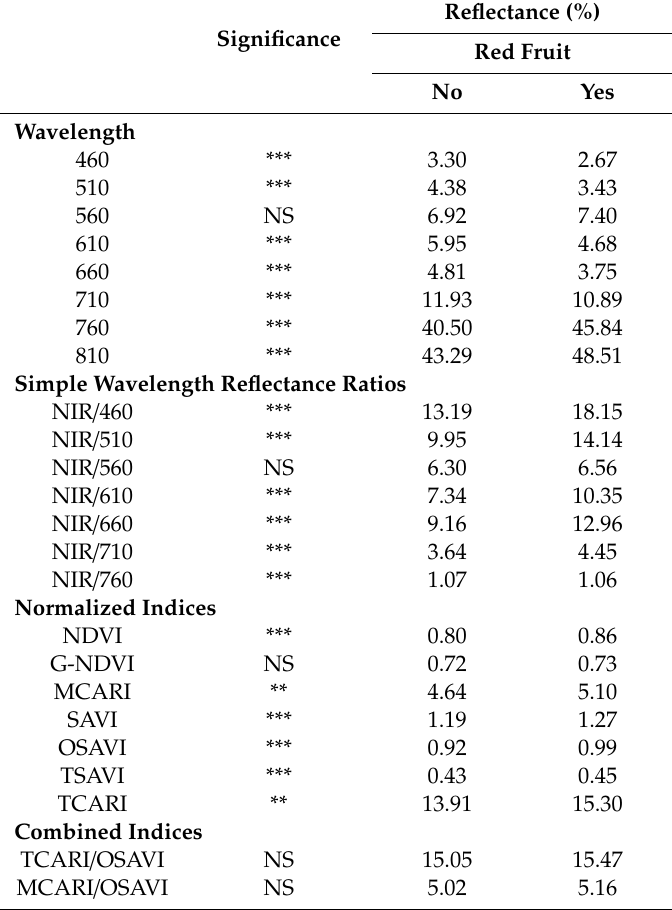
Table 5. Experiment 4#. Statistical significance by ANOVA and mean values of the “red fruit” factor.